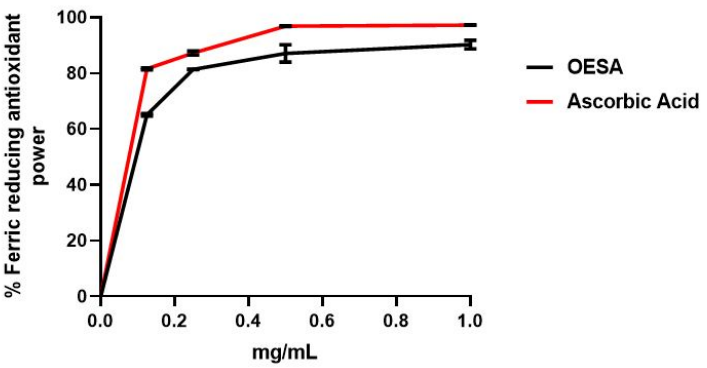
Figure 2. Ferric reducing antioxidant power (FRAP) assay of OESA. Various concentrations of OESA extracts (0 to 1 mg/mL) and acid ascorbic were mixed with FRAP reagents. The reduction of ferric ion (Fe 3+ ) to ferrous form (Fe 2+ ) by OESA produces an intense blue light revealed as a change in absorption at 700 nm. Results were expressed as mean inhibition percentage (%) ± standard deviations (n = 3). Ascorbic acid at various concentrations (0 to 1 mg/mL) was used as standard.